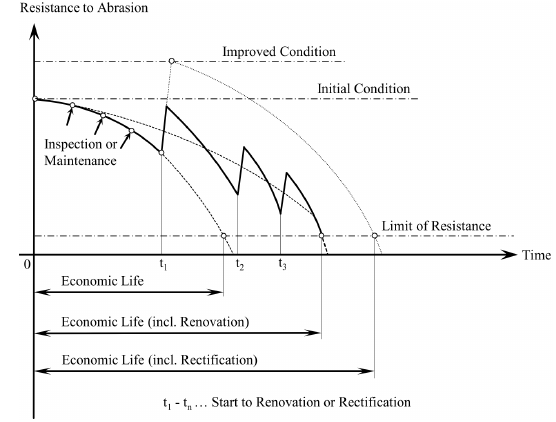
Figure 4: Maintenance of civil engineering works based on (Fechner, 2002) and (DIN31051,